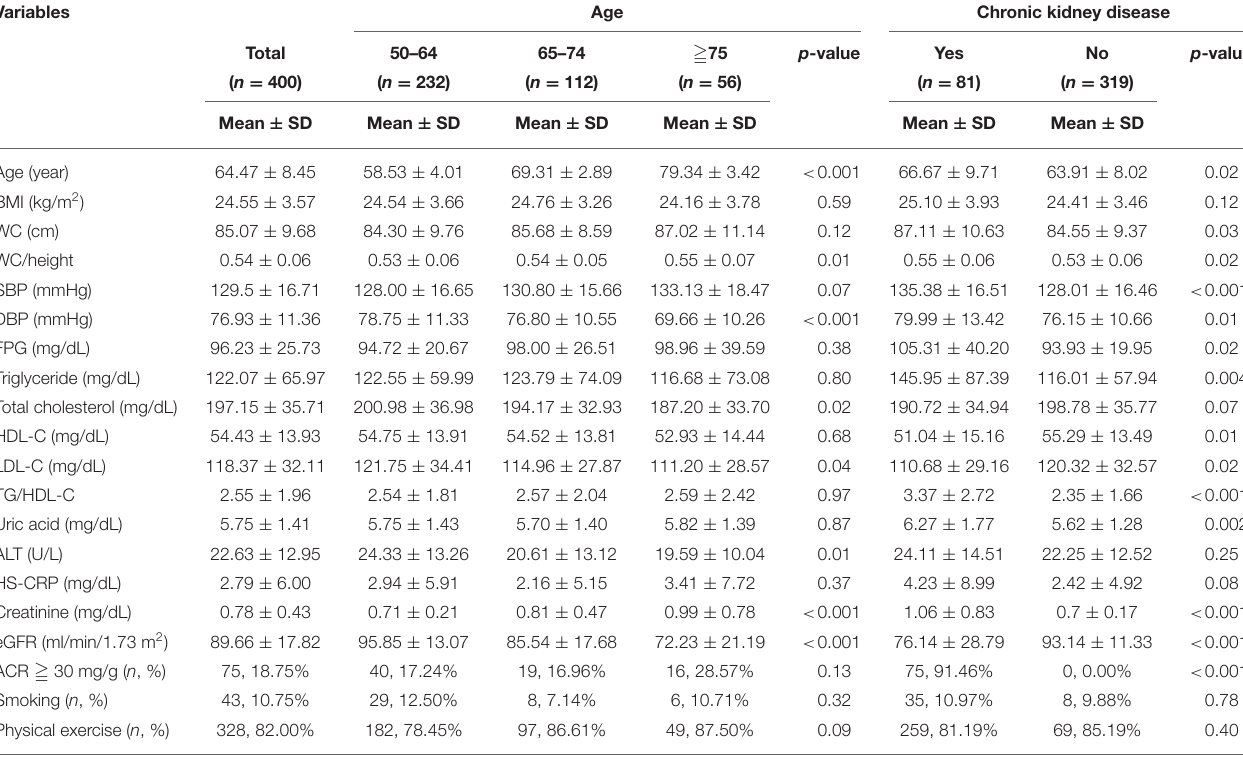
Clinical characteristics are expressed as mean ± SD for continuous variables. P-values were derived from one-way analysis of variance (one-way ANOVA) and independent two-sample t-test for continuous variables, and Chi-squared test for categorical variables. BMI,bodymassindex;WC,Waistcircumference;SBP,systolicbloodpressure;DBP,diastolicbloodpressure;FPG,fastingplasmaglucose;HDL-C,high-densitylipoproteincholesterol; LDL-C, low-density lipoprotein cholesterol; TG, triglyceride; ALT, alanine aminotransferase; HS-CRP, high sensitivity C-reactive protein; eGFR, estimated glomerular filtration rate; ACR, urine albumin creatinine